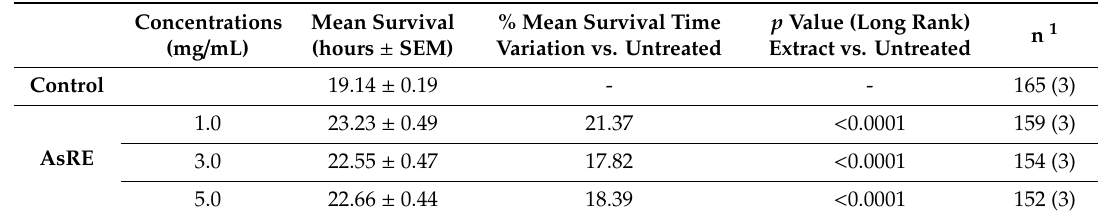
Table 2. Evaluation of resistance to oxidative stress in nematodes treated with the extract. Concentrations Mean (mg / mL)